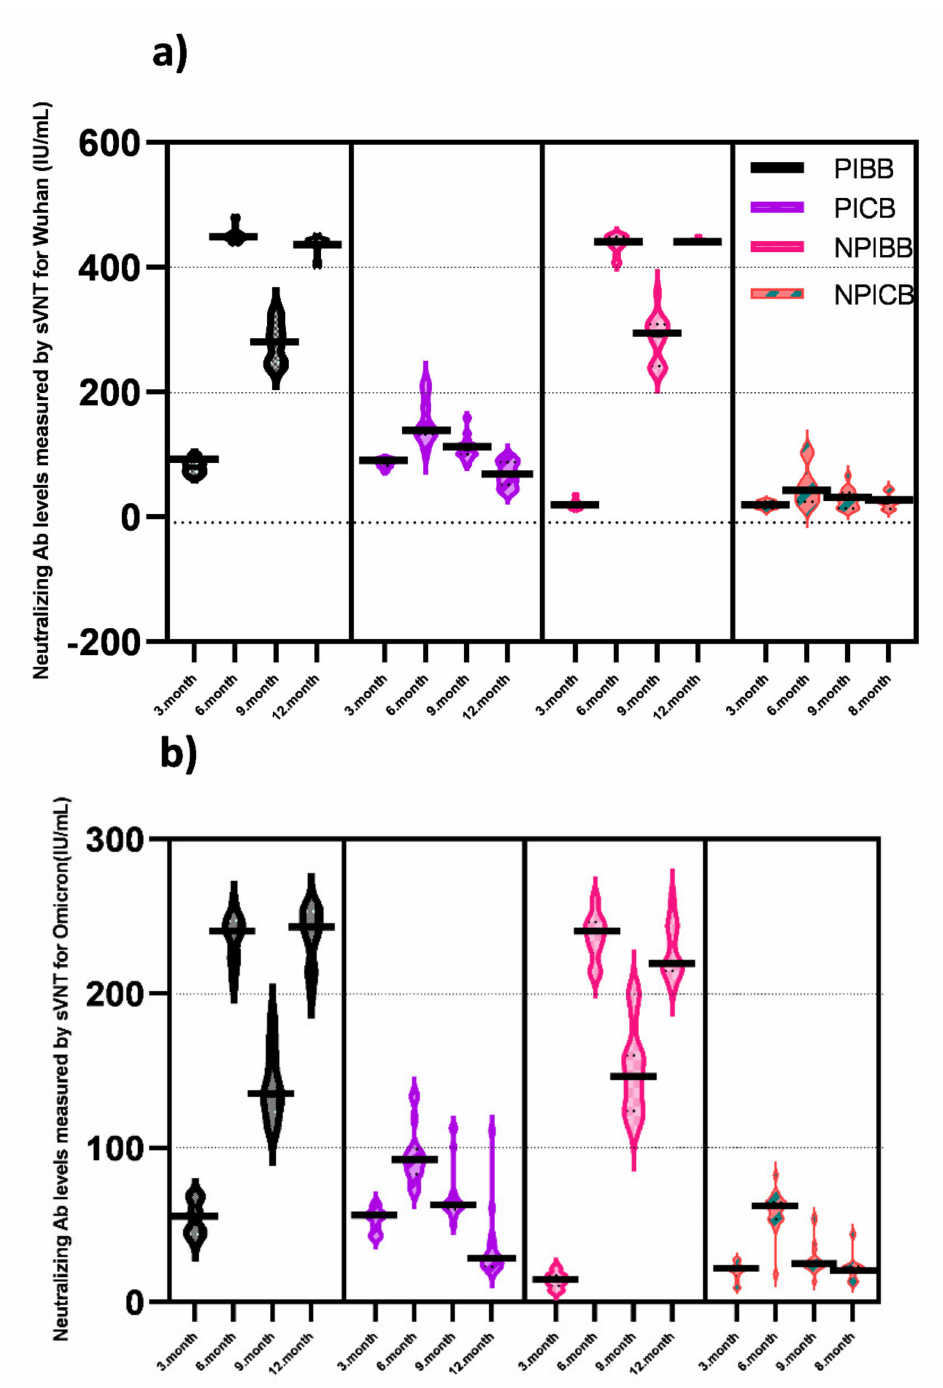
Figure 3. One year comparative evaluation of SARS-CoV-2 Neutralizing Ab levels (IU/mL) measured by sVNT against ( a ) Wuhan and ( b ) Omicron of PIBB, PICB, NPIBB, and NPICB groups in four sampling periods with 3-month